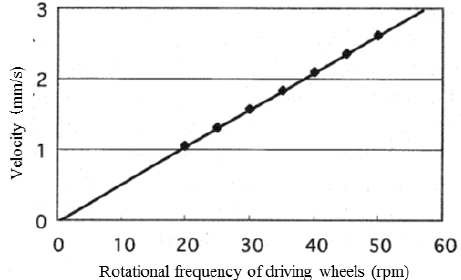
Figure 12. The relationship between microrobot speed and rotational frequency of driving wheel (straight line movement). The points show the calculation results. The solid line shows the regression line derived from these data.